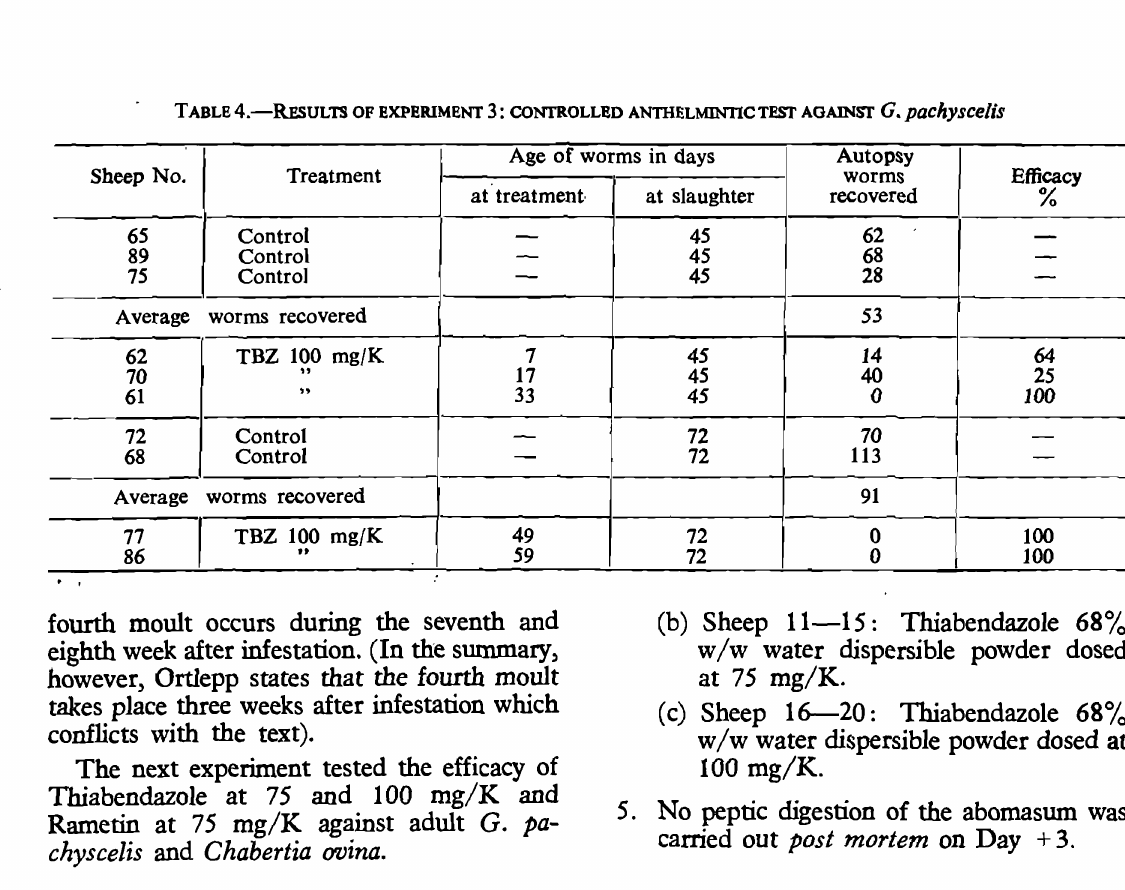
Experiment 4: Controlled Anthelmintic